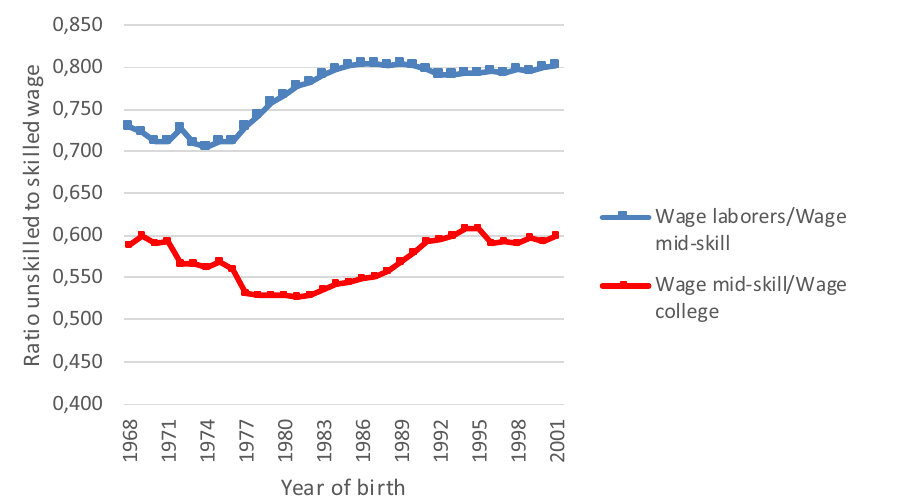
Fig. 2 Wage structure by skill level at age 17, by year of birth: Spanish males. a. Wages of laborers are medians among group 10 workers aged 16–45 years in province year. We take medians in three age cells (16–26, 26–35, 35–45) and average them. b. Wage of mid-skill workers are medians among groups 3–9 of workers aged 25–45 age in province year. We take medians in two age cells and average them. c. Wages of college workers are medians among groups 1–2 of workers in 25–45 age in province year. We take medians in three age cells and average them. In the regressions, we use the cohorts born between 1969 and 1984.